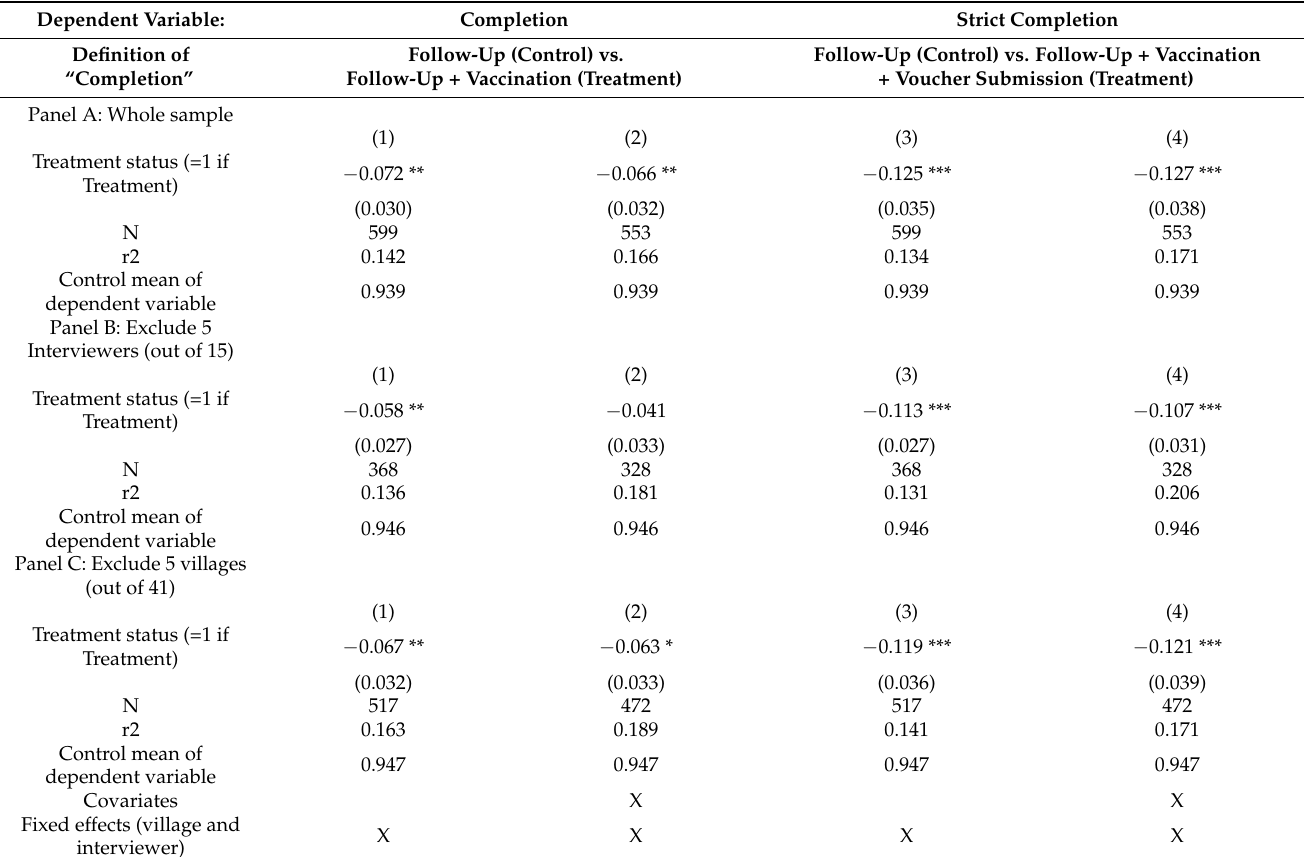
Table 6. Main results with interviewer fixed effects.